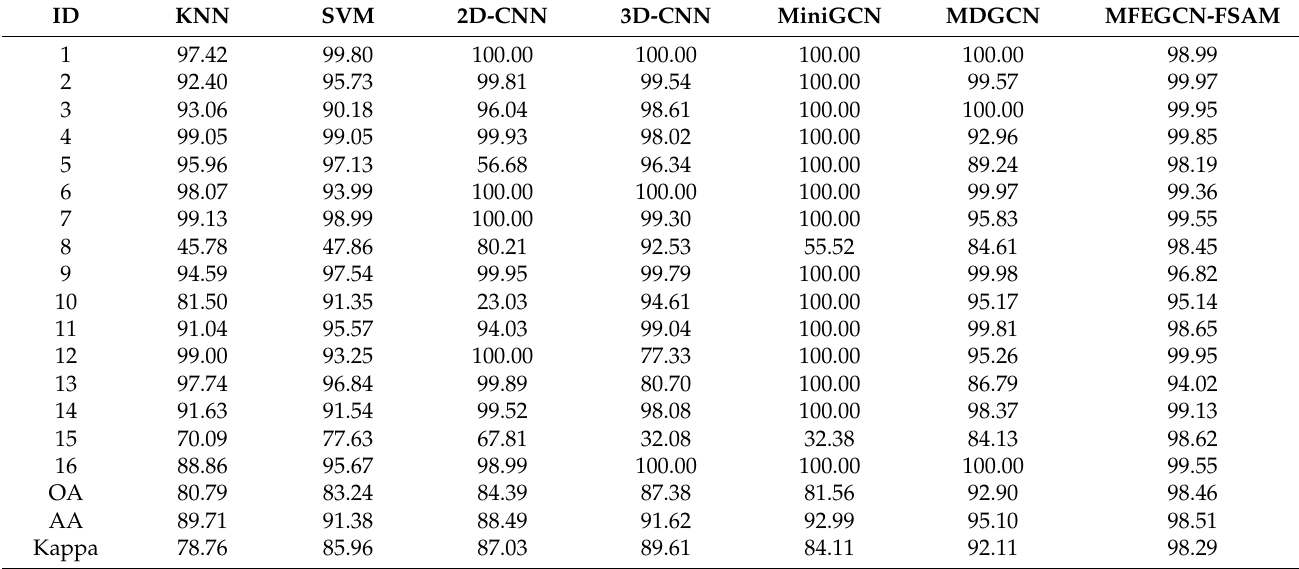
Table 8. Classification performance of different methods on Salinas dataset